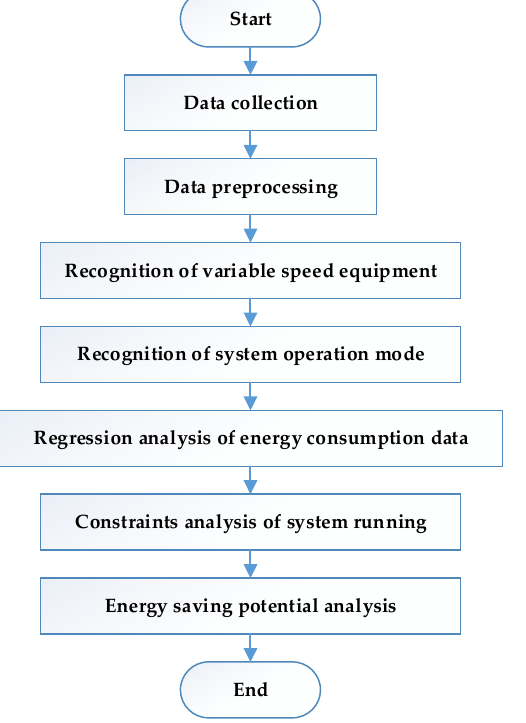
Figure 1. Flow chart of the proposed energy-saving potential analysis method based on data min-